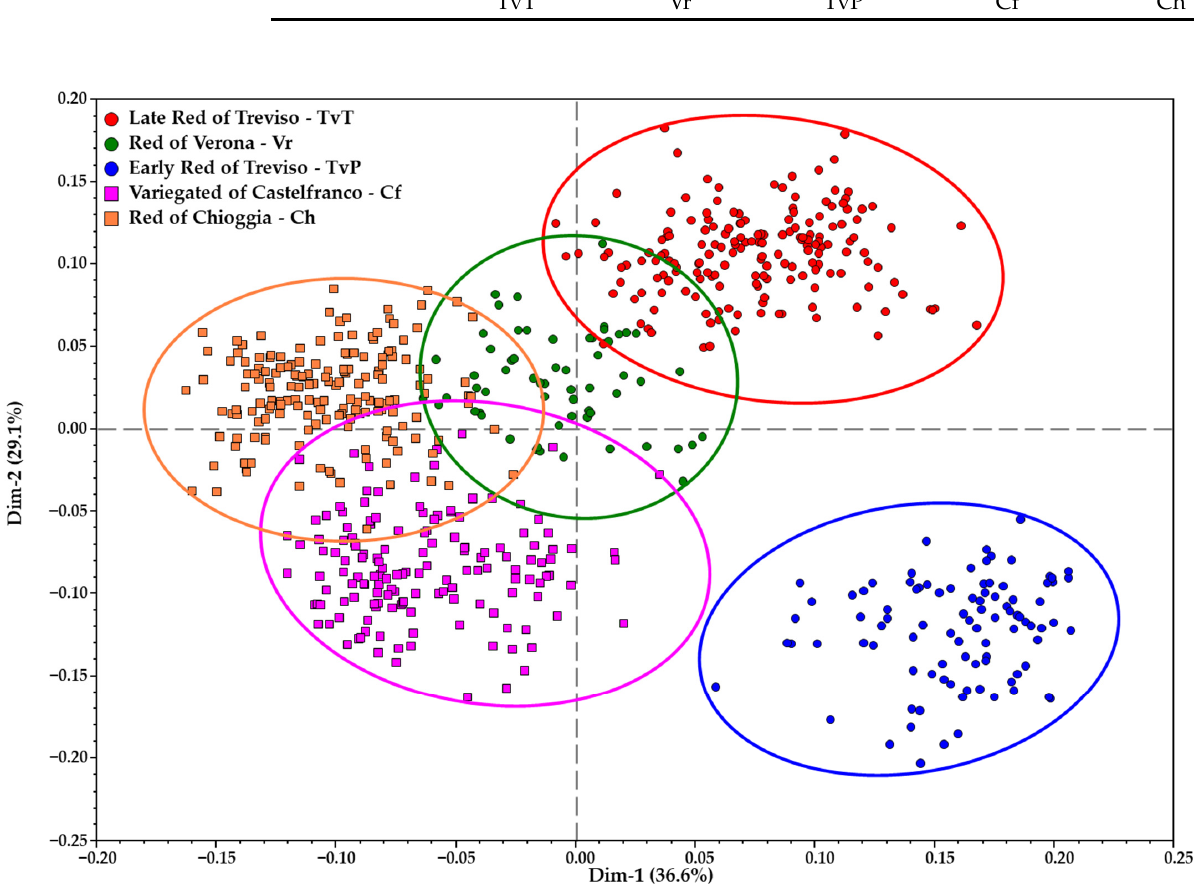
Figure 4. Principal Coordinate Analysis (PCoA) based on the GS matrix calculated with the Dice’s coefficient in all possible pairwise comparisons using the whole DNA marker data set. Samples are labelled following the biotype of belonging and their centroids are subgrouped to better represent overlapping areas. Pure C. intybus biotypes are labelled with circles, while interspecific ones using squares.